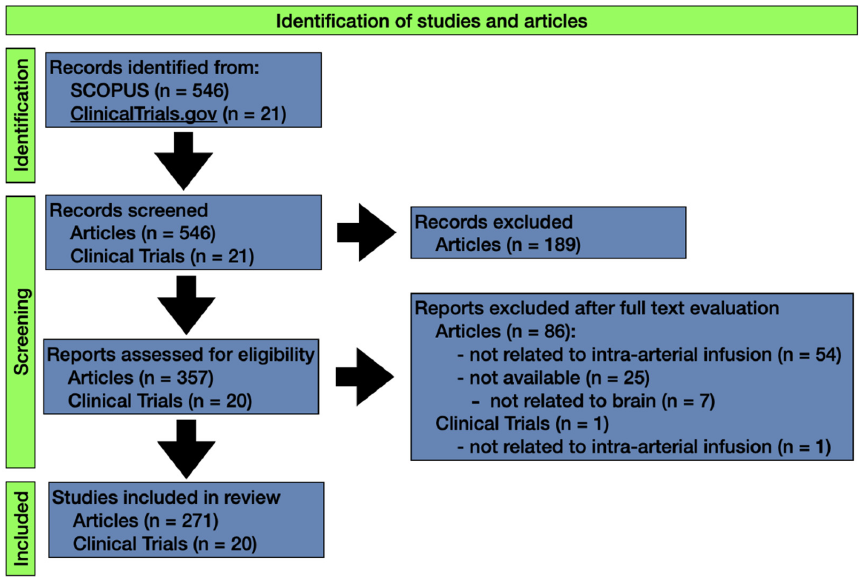
Figure 1. Methodological approach to identify articles and clinical trials on intra-arterial brain tumor therapy via databases and registers.